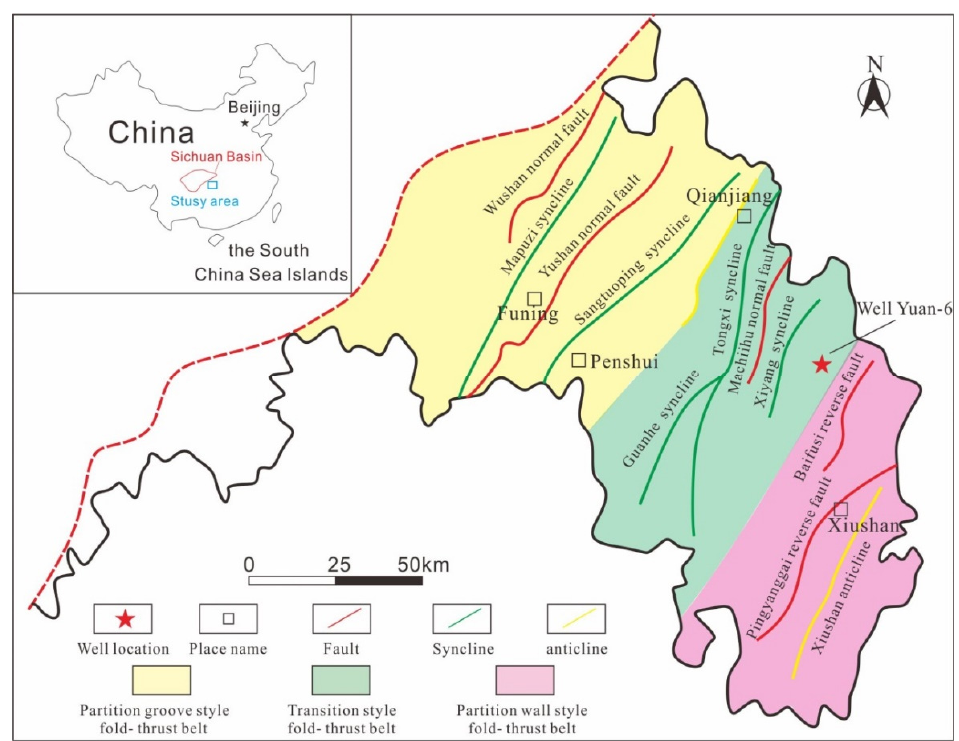
Figure 1. Structural characteristics of study area with location of well Yuan-6.